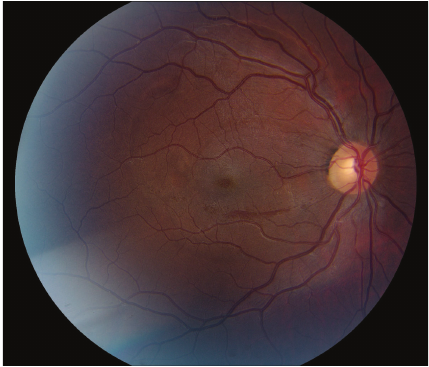
Figure 2: Color fundus photo of the left eye on the day of presen- tation. Note the large intraretinal and flame shaped hemorrhages superior to the optic disc.